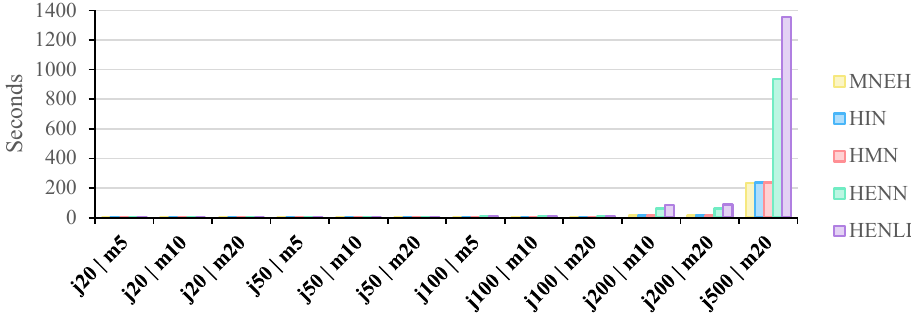
Fig. 9. Graphs of construction heuristics’ execution times with preventive maintenance policy